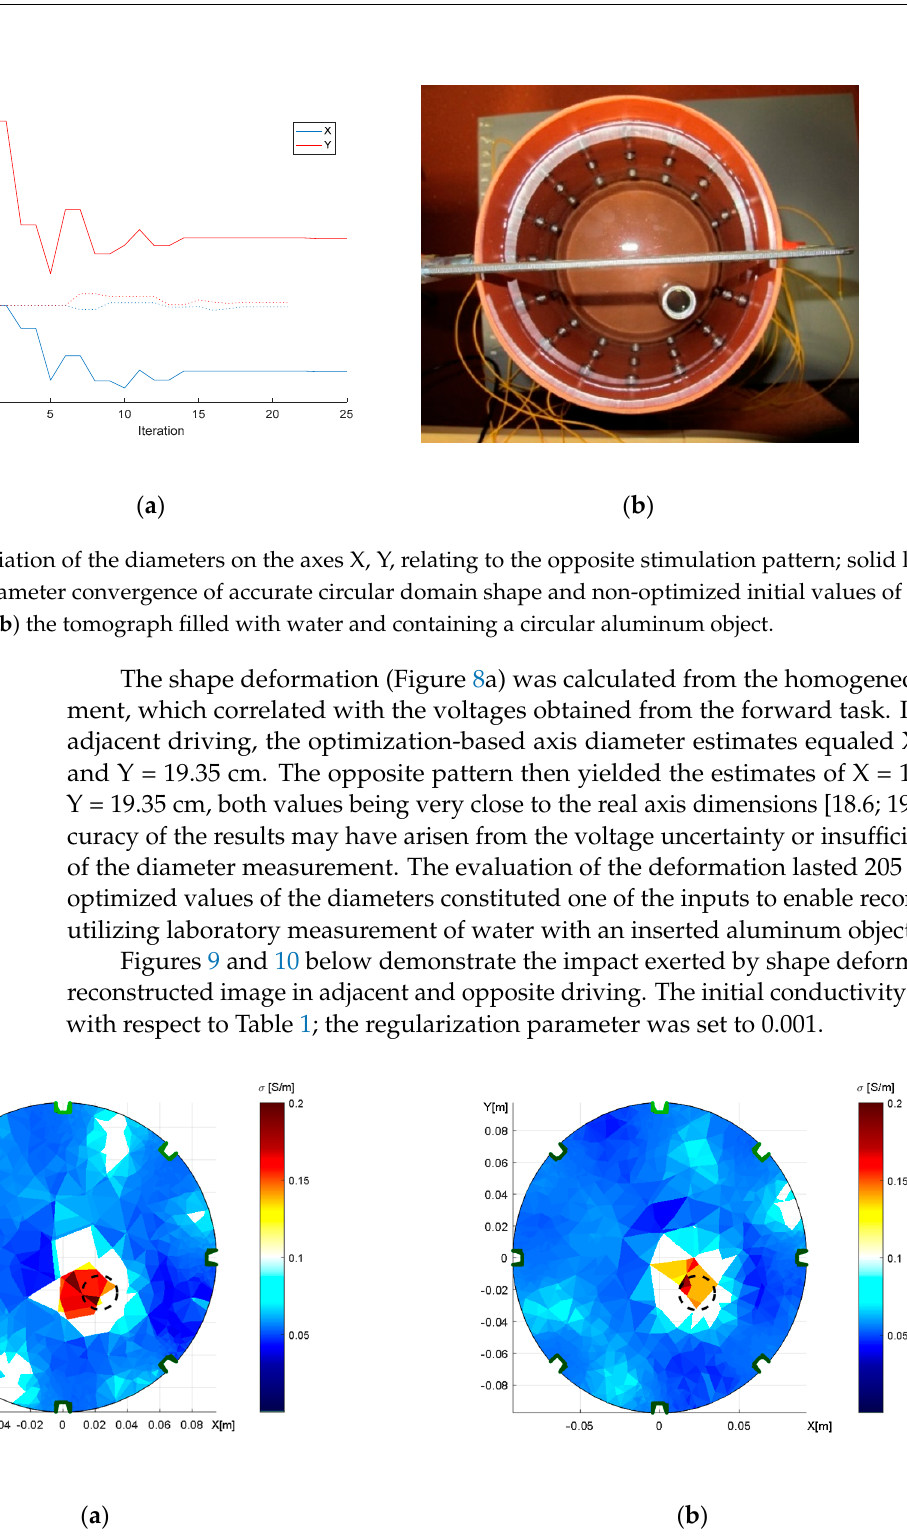
Figure 9. The distribution of conductivity in the water medium, obtained through adjacent driving; an aluminum object is inserted, and the tomograph’s axial dimensions correspond to X = 19.4 cm and Y = 18.6 cm. The images: ( a ) a wrongly selected circular shape; ( b ) the correct elliptic domain.